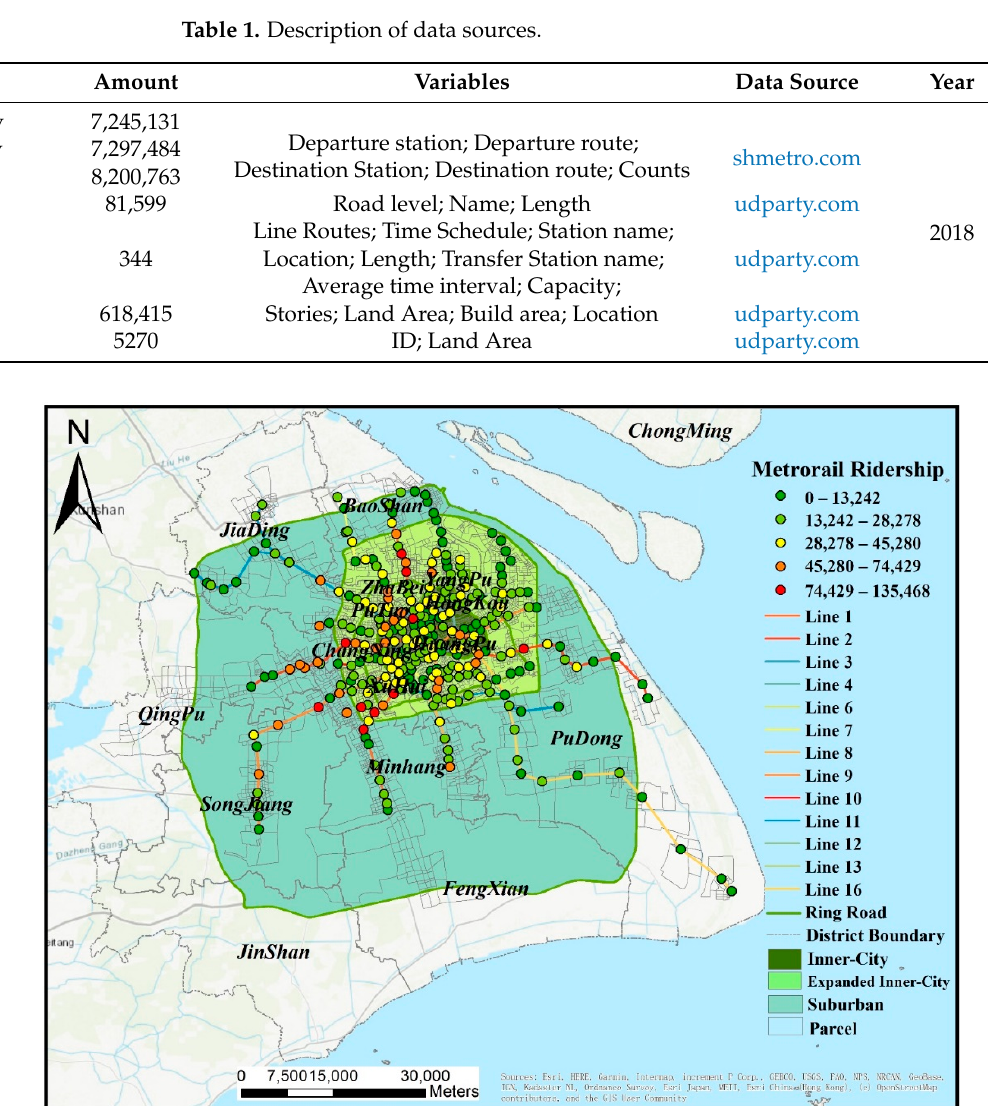
Figure 1. Metrorail Ridership on a workday in Shanghai.